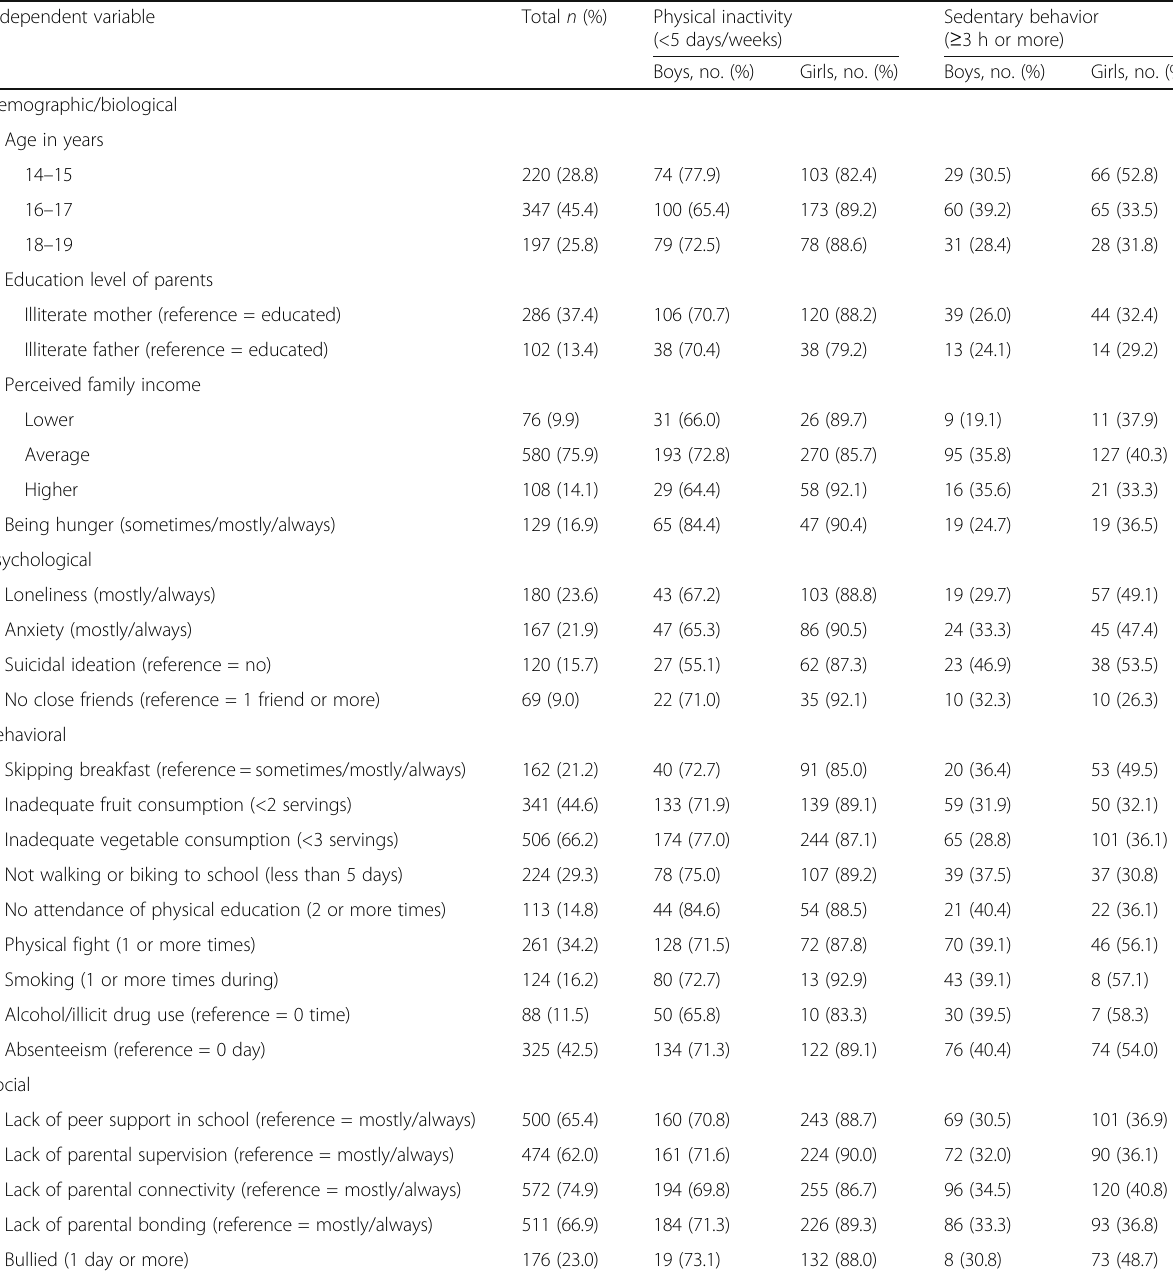
Table 1 PI and SB by independent variables Independent